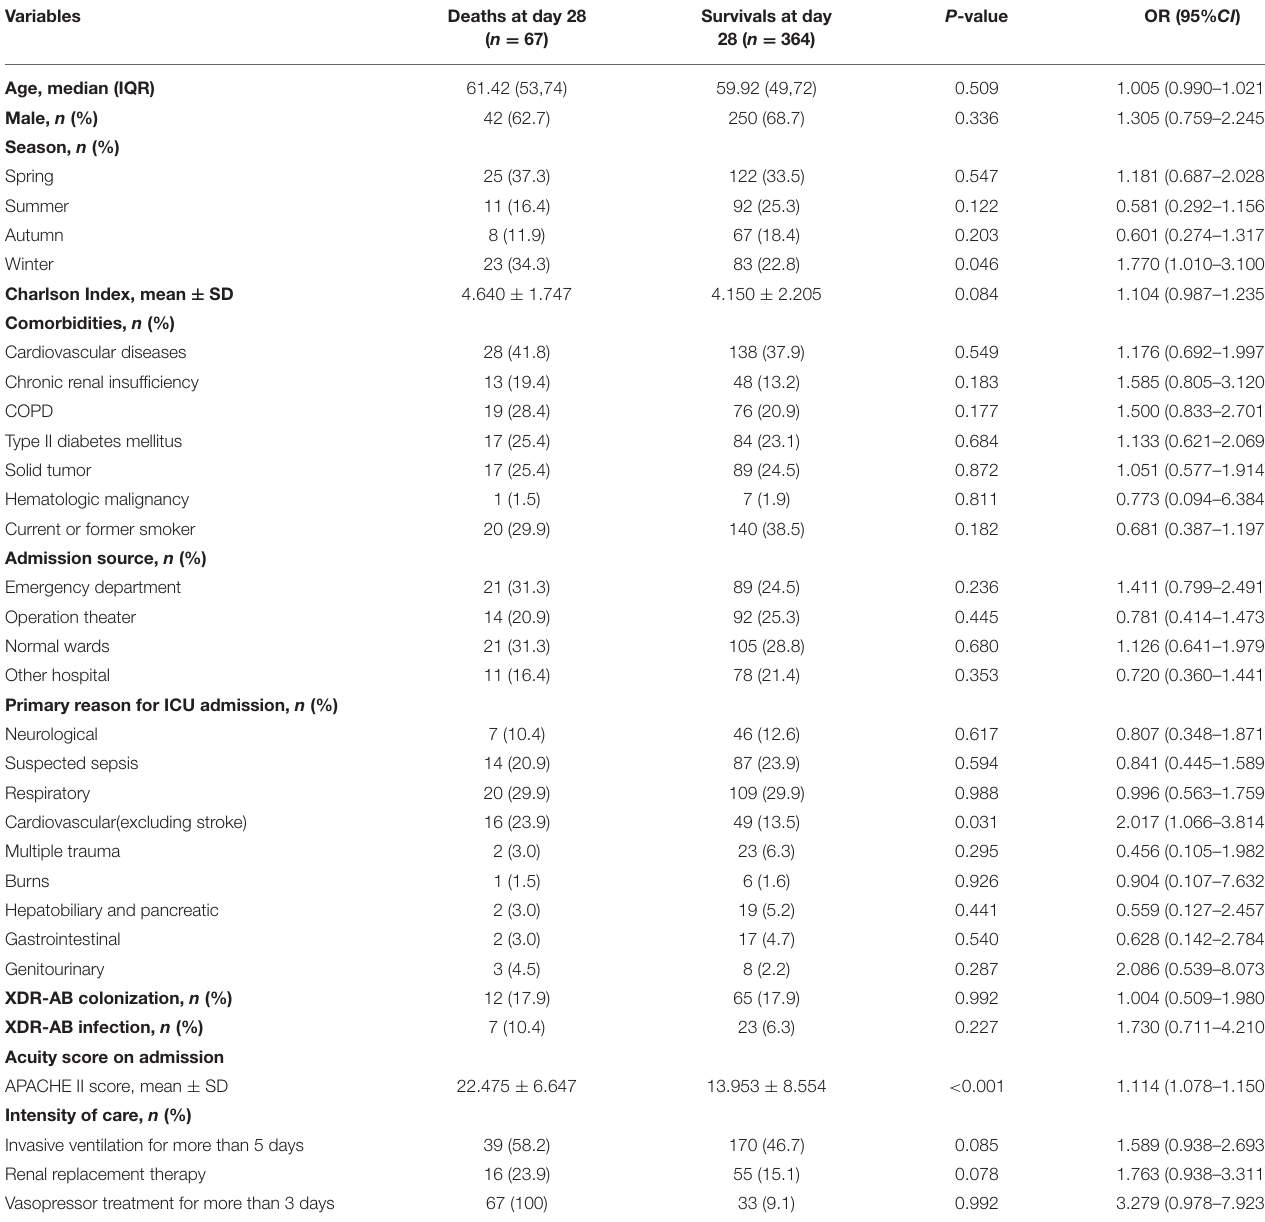
TABLE 2 | Univariate analysis of factors associated with 28-day mortality. Variables